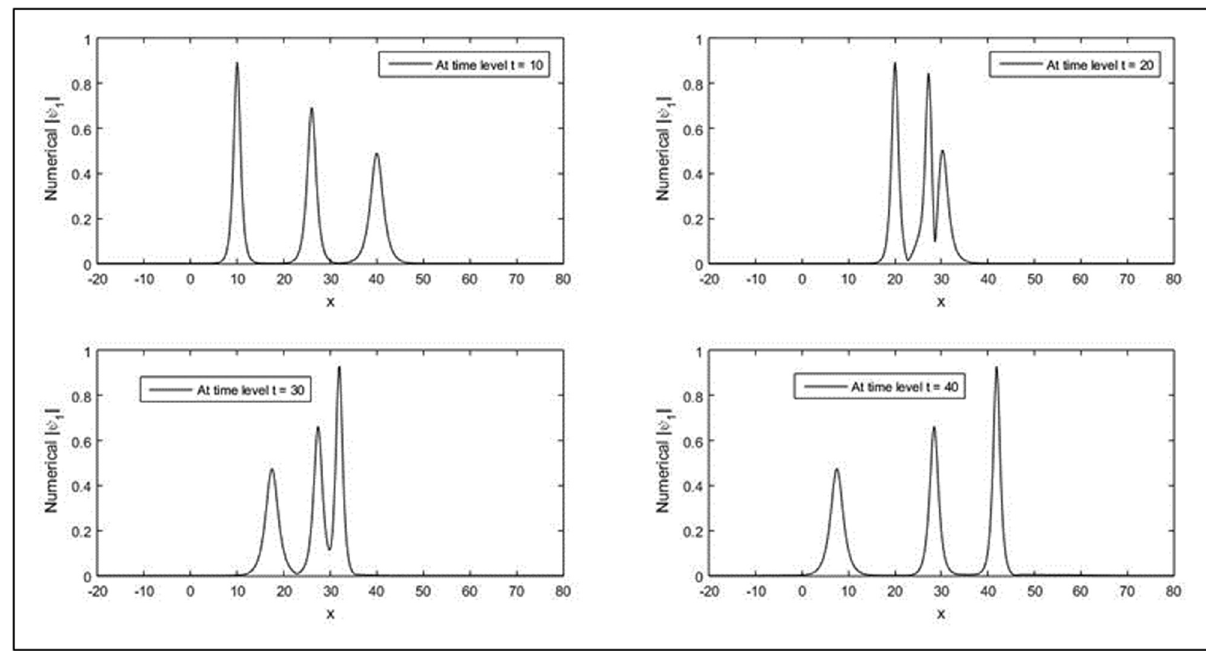
Figure 9: Interaction of three solitons for fi rst - wave amplitude for